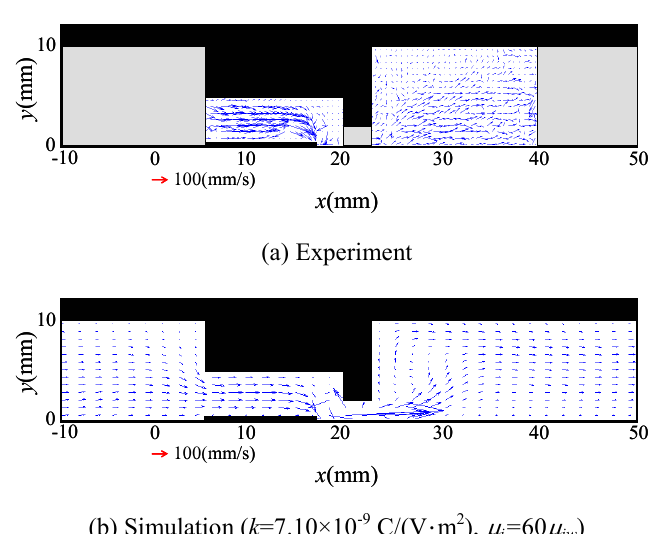
Fig.10 Comparison of measured flow field with simulated one for small-depth pump